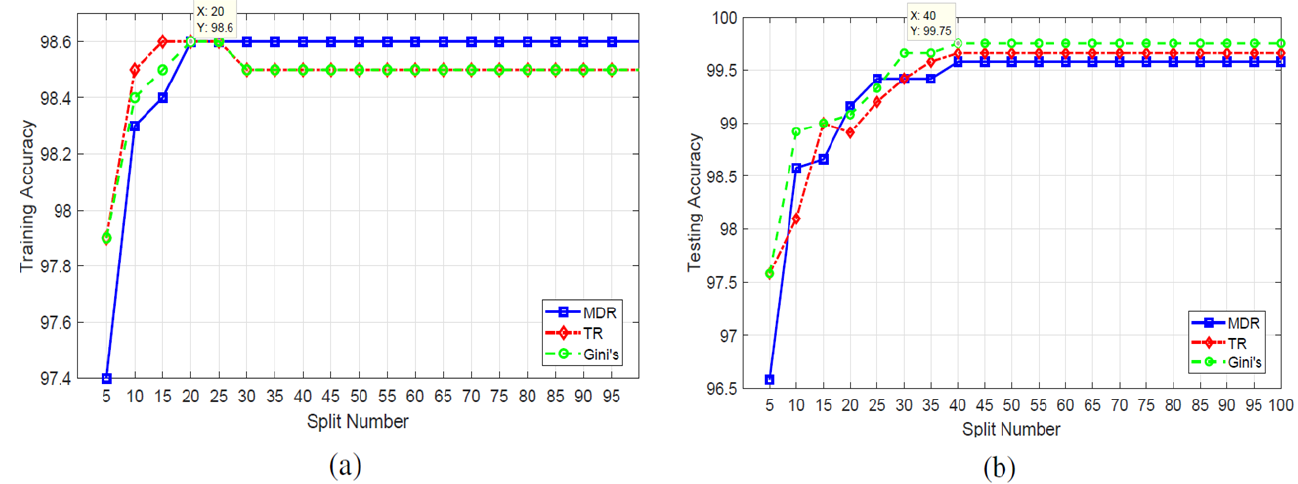
Figure 35. Analysis results of bearing faults: ( a ) training accuracy; ( b ) testing accuracy. Reproduced with permission of [96].